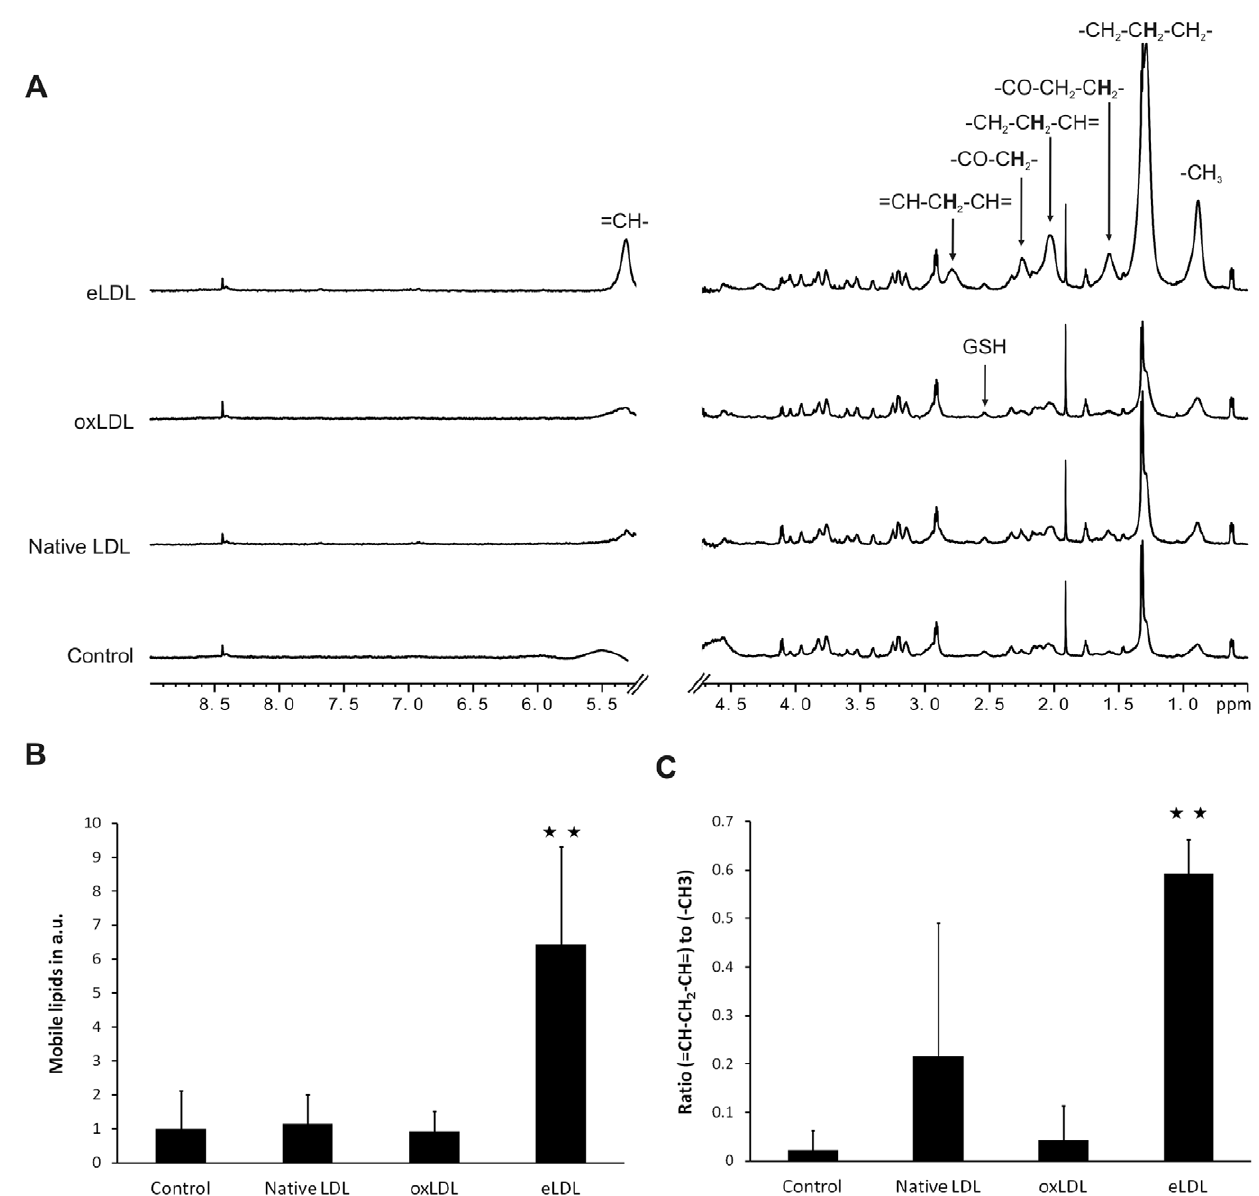
Figure 2. Changes in NMR-visible lipids as consequence of loading macrophages with modified LDL. (A) Moderate mobile lipid signals were present in NMR spectra of native macrophages (control). Loading with native LDL or oxLDL did not result in any significant increase of mobile lipid intensities, whereas eLDL loading gave rise to a dominant lipid signal increase. NMR spectral parameters: 800 MHz spectrometer frequency, gradient-based water suppression pulse sequence (zgesgp) with additional water presaturation, 3.7 s repetition time, temperature: 5 u C. Spectra were normalized to protein and/or glutathione (GSH) signal intensities. Spectral annotation according to dominant contributions to NMR signals. (B) The NMR-visible lipid content, i.e. the integral in arbitrary units over the deconvolved NMR signal of the terminal methyl group of fatty acid chains. (C) The average percentage of bis- allylic methylene per fatty acid chain in control macrophages and macrophages loaded with native LDL, oxLDL and eLDL, i.e. the ratio of NMR-visible bis- allylic methylene groups and methyl groups. Deconvolved peaks of (-CH=CH-CH 2 -CH=CH-)- and (-CH 3 )-protons were integrated. Mean and standard deviation of five samples from different donors, N=5 except for ‘‘LDL’’ (N=4). Mann-Whitney U test: **p , 0.01.